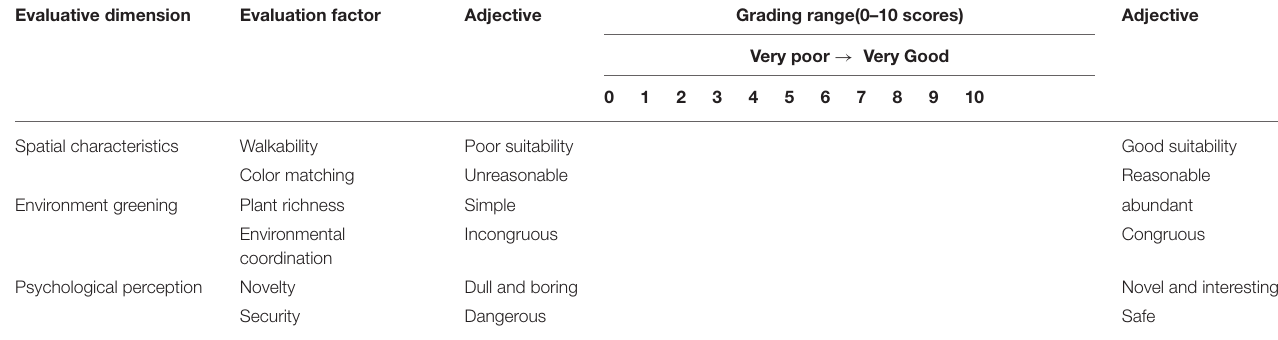
TABLE 3 | The questionnaire for Landscape perception evaluation. Evaluative